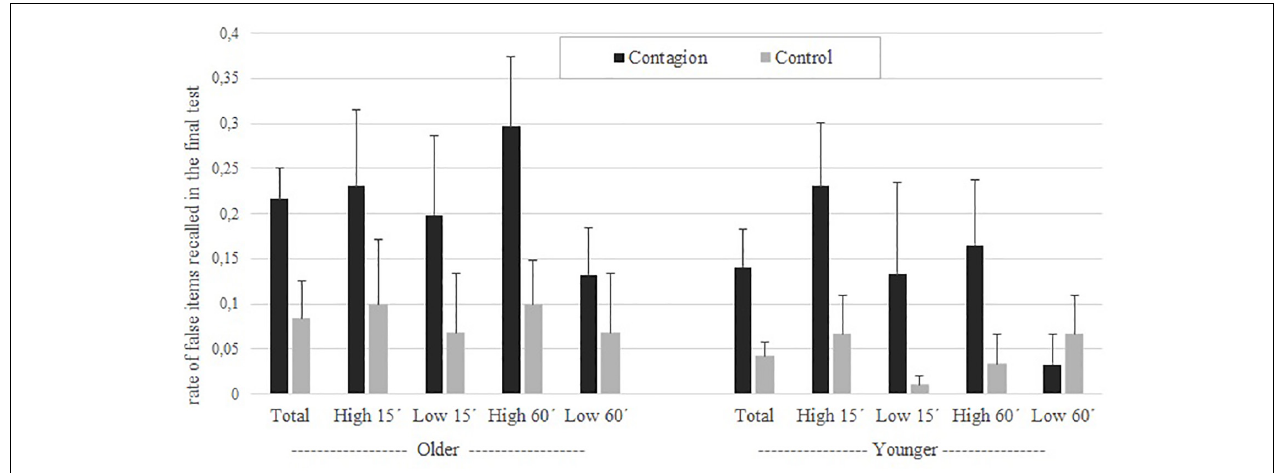
FIGURE 1 | Rate of false items recalled between contagion and control conditions in both older and younger participants. Dark bars show contagion rate whereas light ones depict control performance. Corresponding standard errors are drawn over each bar.